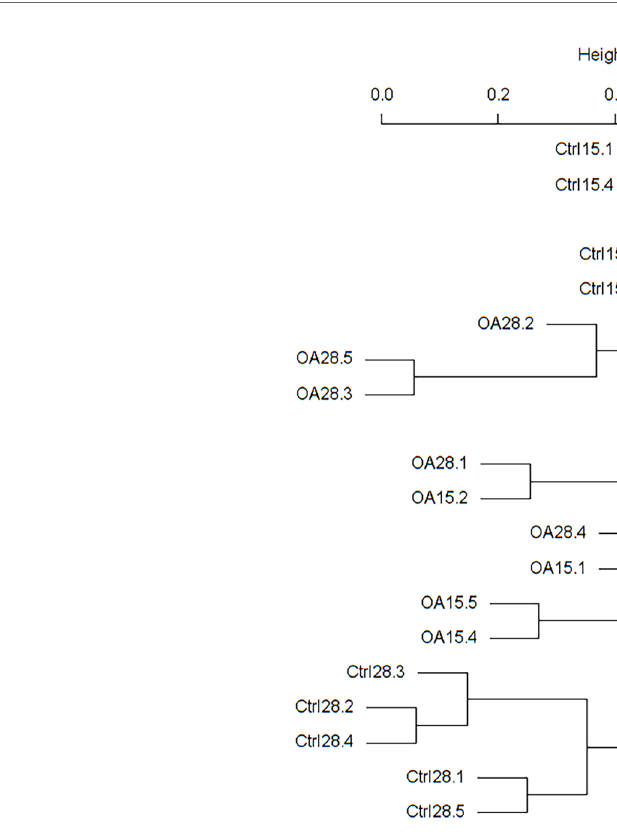
FIGURE 5 | UPGMA phylogenetic tree constructed based on weighted UniFrac